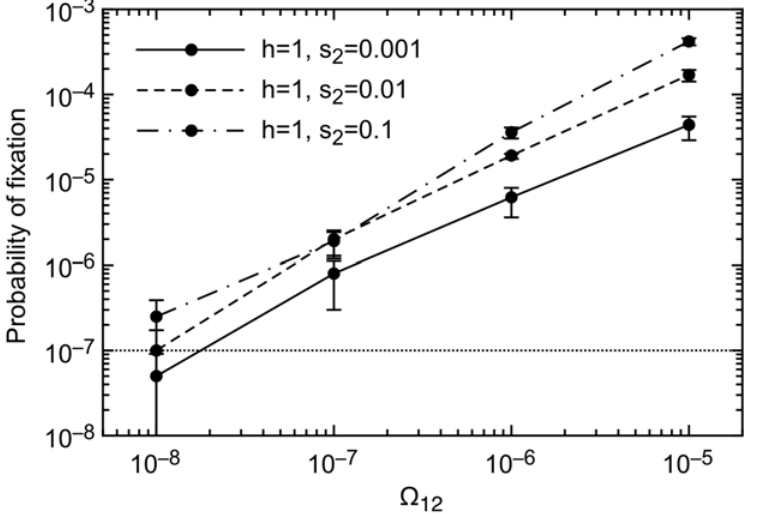
Figure 8. Fixation probabilities starting from a single copy. prf + allele fixes above neutral expectations (10 2 7 ) when the transition probability to environment 2 is greater than 10 2 8 . All parameters are equal to values in Figure 6, with the additional parameter m prf + =10 2 9 . Results are based on 10 6 replicates ( V 12 =10 2 5 ), 5 6 10 6 replicates ( V 12 =10 2 6 ), 2 6 10 7 replicates ( V 12 =10 2 7 ) and 2 6 10 7 replicates ( V 12 =10 2 8 ).